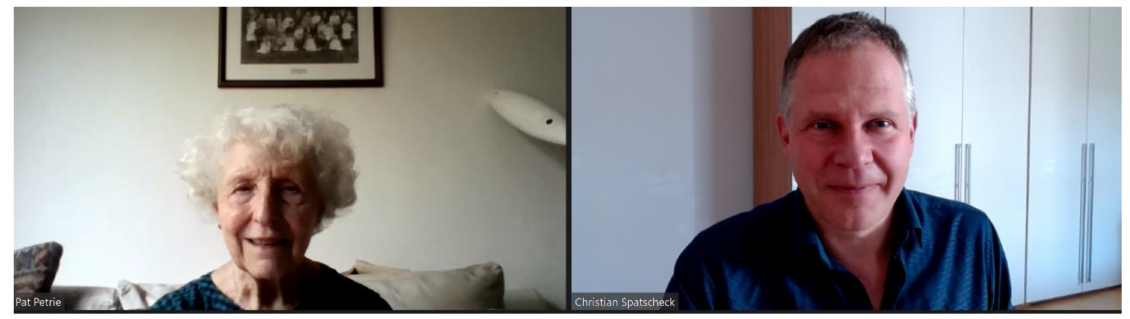
Figure 1. Pat Petrie and Christian Spatscheck (Source: Christian